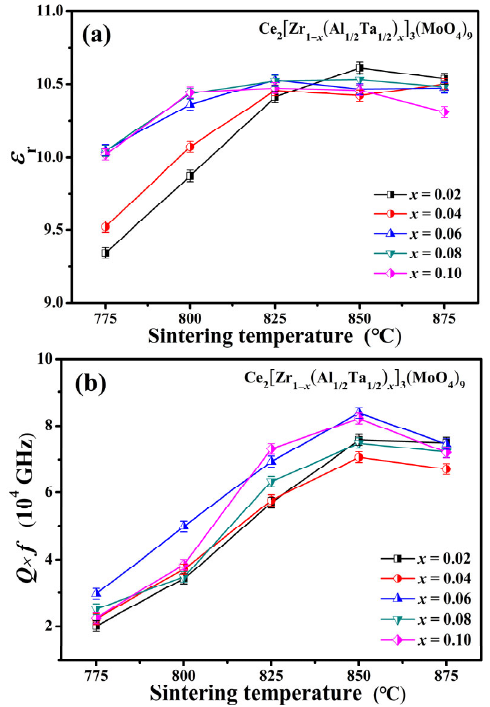
Fig. 7 (a) ɛ r values of CZMAT ceramics as a function of sintering temperature; (b) Q × f values of CZMAT ceramics as a function of sintering temperature.